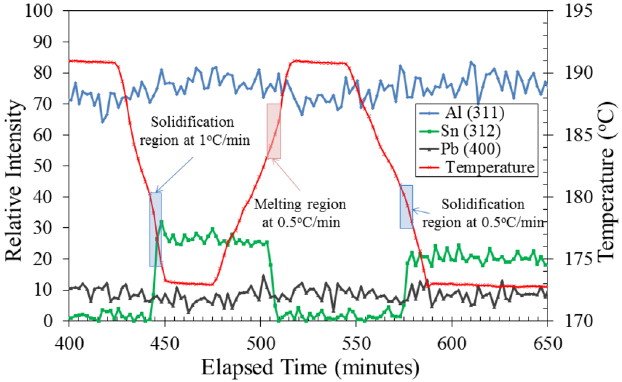
Fig. 5. Relative intensity (left hand scale) for MGA sample during temperature cycling. The local temperature experienced by the material in the beam volume is shown in red, refer to right hand